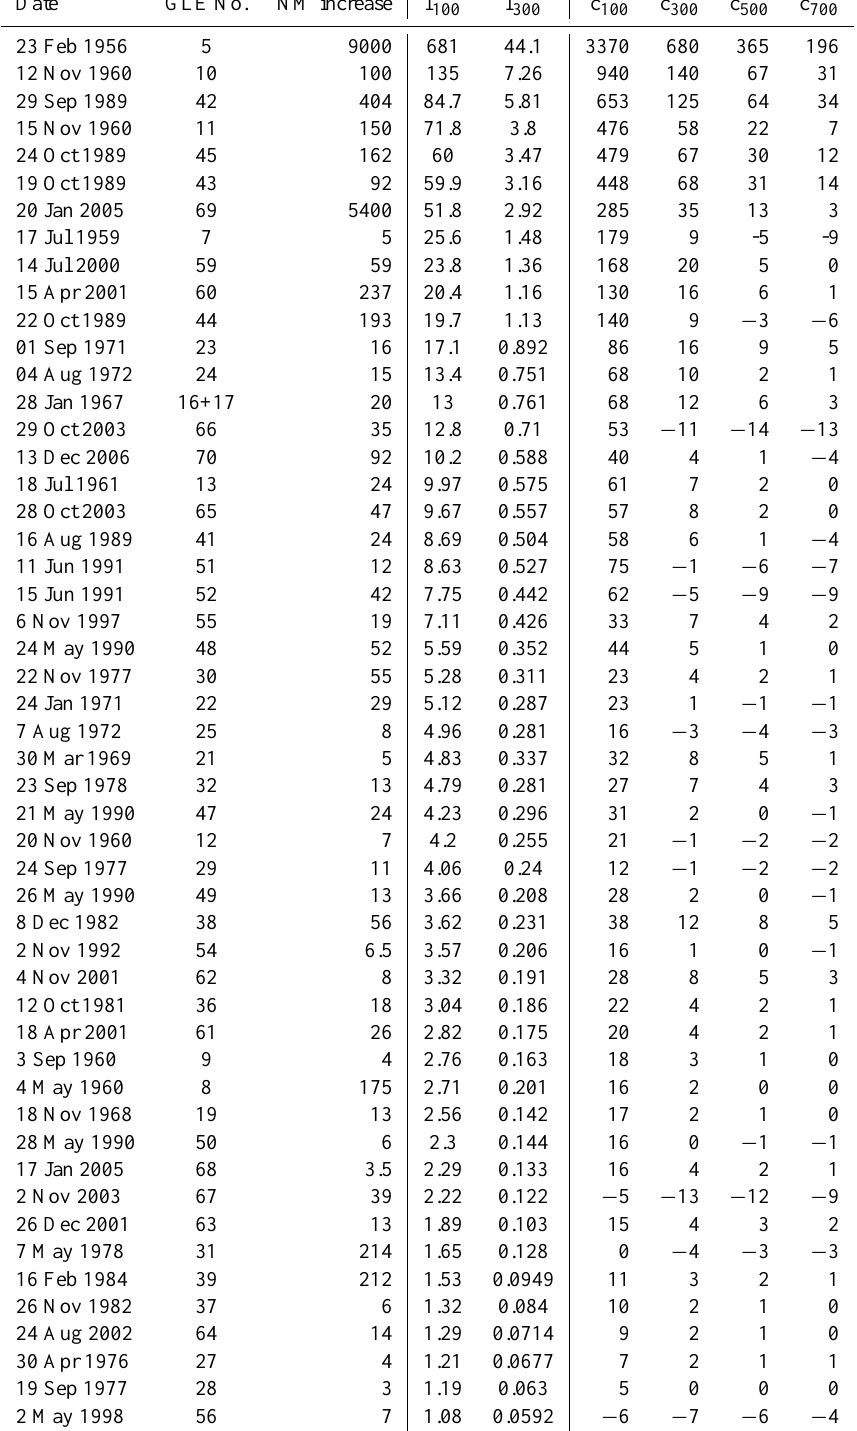
Table 1. Computed ionization effect of GLE events, ordered according to their ionization effect I 100 at 100g/cm 2 . The official GLE number, the date, and the strength (maximum increase in % of NM count rate – see Duggal (1979); Belov et al. (2010)) of the events are given in the first three columns. Daily mean ionization due to SEP only at 100 and 300g/cm 2 atmospheric depths is given in 10 4 (gs) − 1 as I 100 and I 300 , respectively. Relative CRII effect c in % (Eq. 5) at different depths h is shown in columns #6–9). All the values are given for the polar